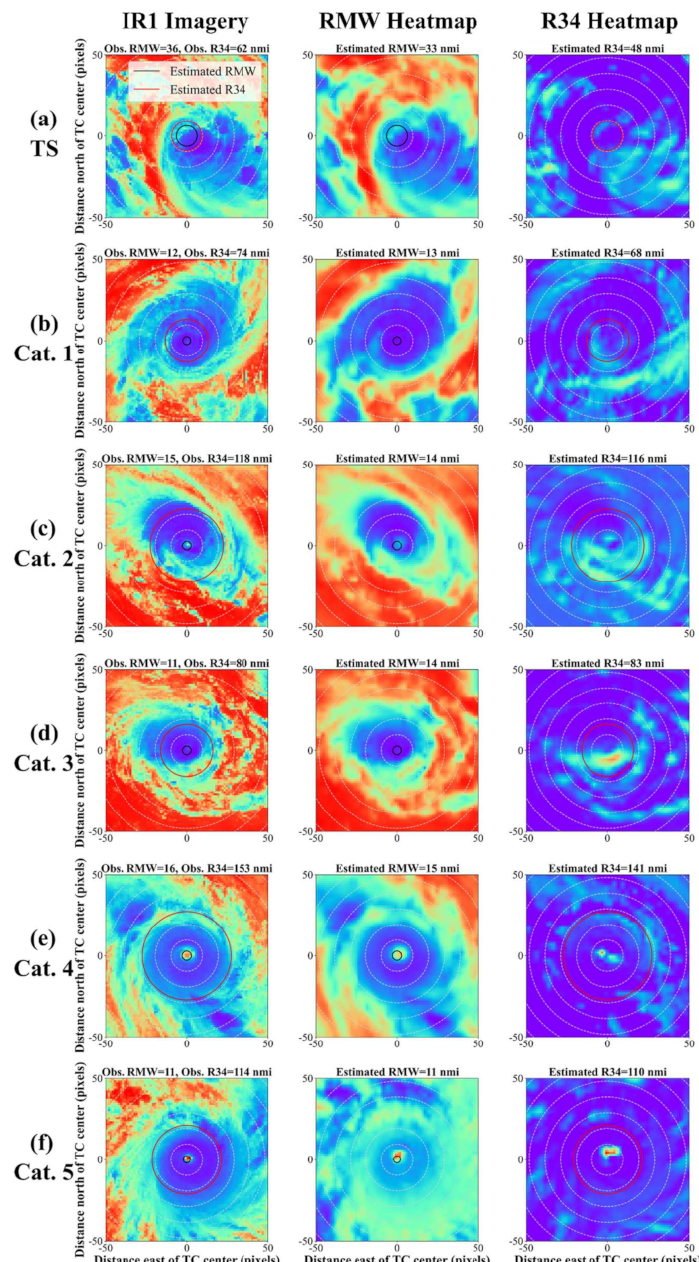
Figure 10. Examples of COMS Meteorological Imager infrared 1 (IR1) images (left panels), heatmaps of the radius of maximum wind (RMW) (center panels), and radius of 34 kt wind (R34) (right panels) calculated using a gradient-weighted class activation mapping (Grad-CAM) for tropical cyclones (TCs) based on the Saffir–Simpson Hurricane Wind Scale. ( a ) Tropical storm (TS) and category ( b ) 1, ( c ) 2, ( d ) 3, ( e ) 4, and ( f ) 5 TCs. The solid black and red circles represent the RMW and R34, respectively, which were estimated using the TC-SEM proposed in this study. The images were randomly selected according to TC intensity. The axis units are pixels (1 pixel = ~12